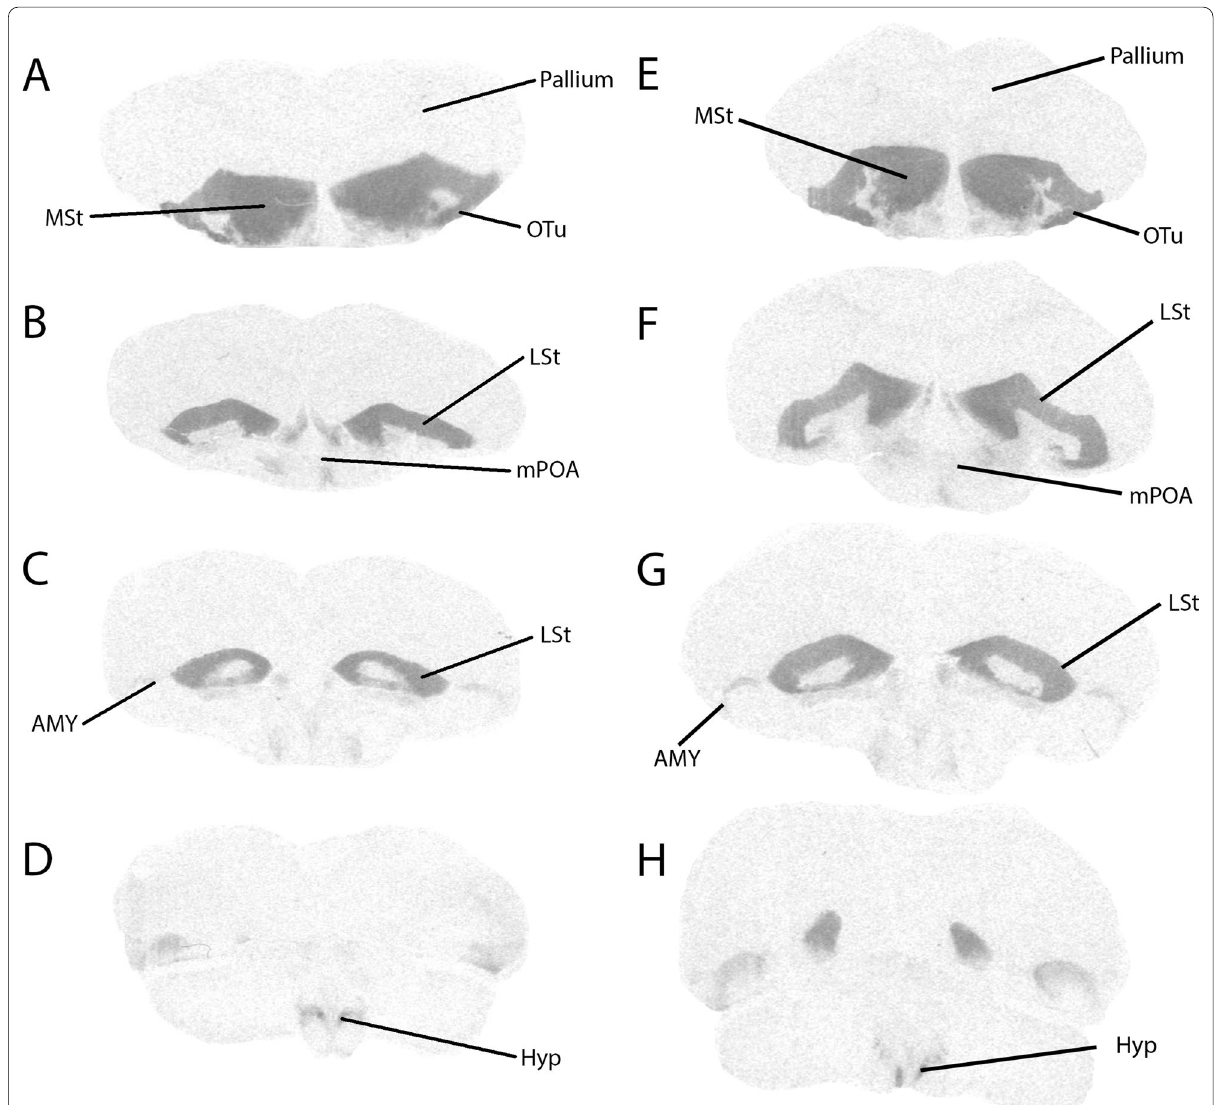
Fig. 1 Representative autoradiograms illustrating [3H]Nisoxetine binding of norepinephrine transporters (NET) in male ( a – d ) and female ( e – h ) quail brains. a – d and e – h panels were sliced on the coronal plane and are presented from rostral to caudal. OTu, olfactory tubercle; MSt, medial striatum; LSt, lateral striatum; mPOA, medial preoptic area; AMY amygdala; and Hyp,